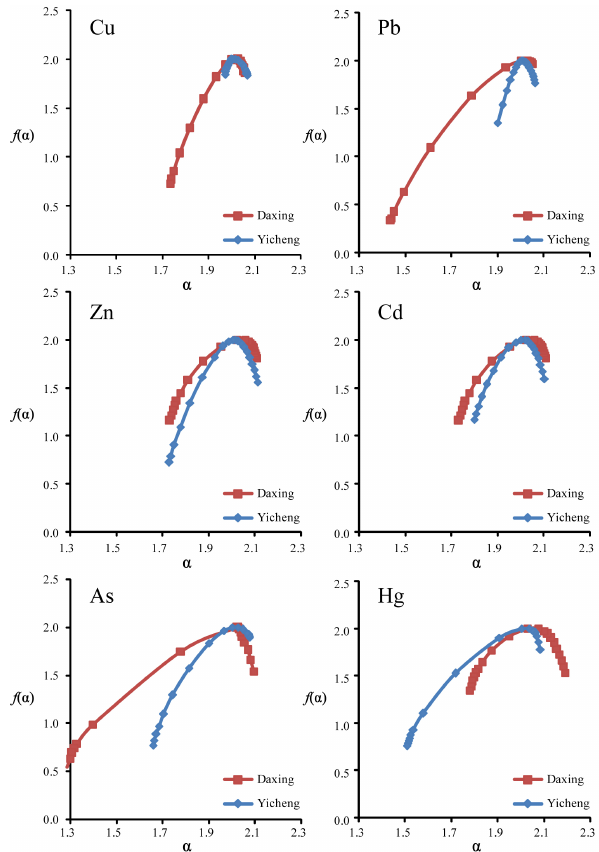
Figure 3. Multifractal spectra ( f (α) vs. α ) of the soil geochemical data from the Daxing and Yicheng areas.